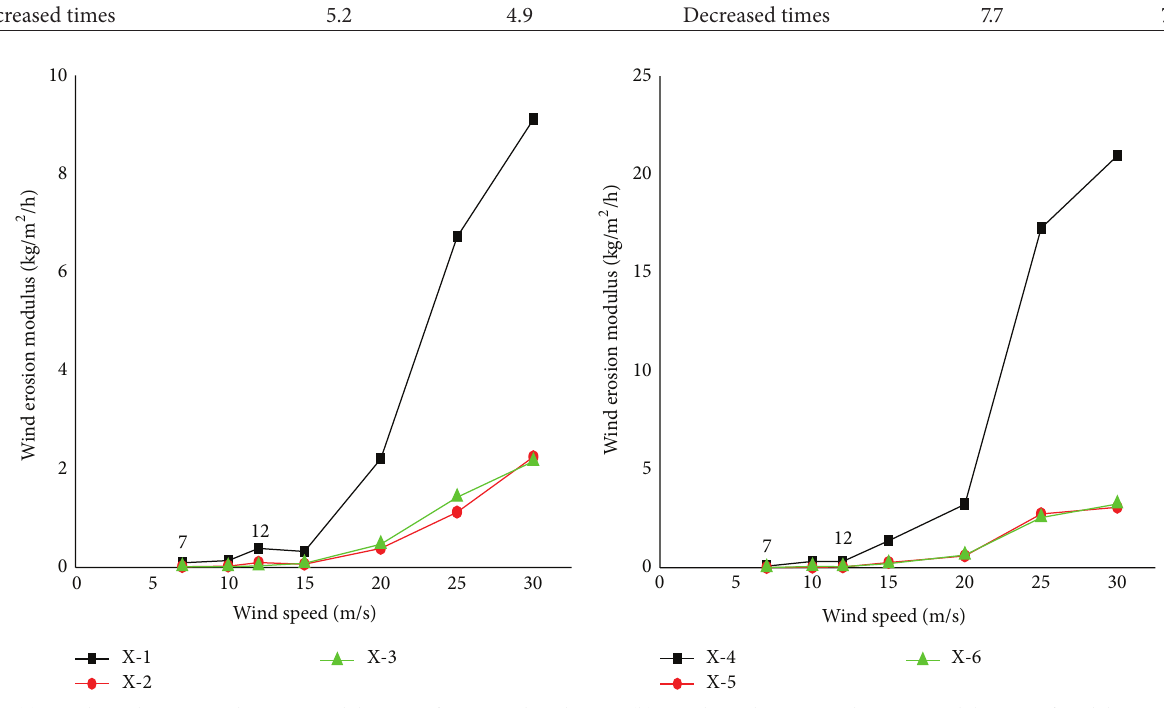
(b) Wind speed versus wind erosion modulus curve for adobe Figure 7: Wind speed versus wind erosion modulus